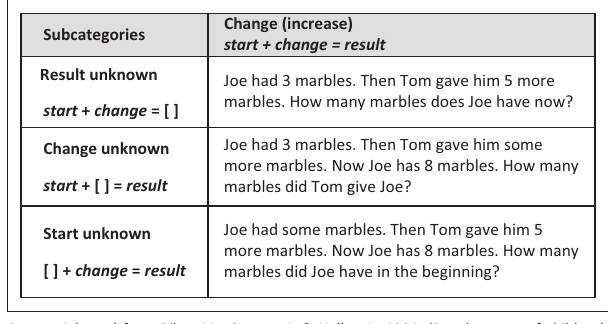
FIGURE 5: Subcategories created by changing the position of the